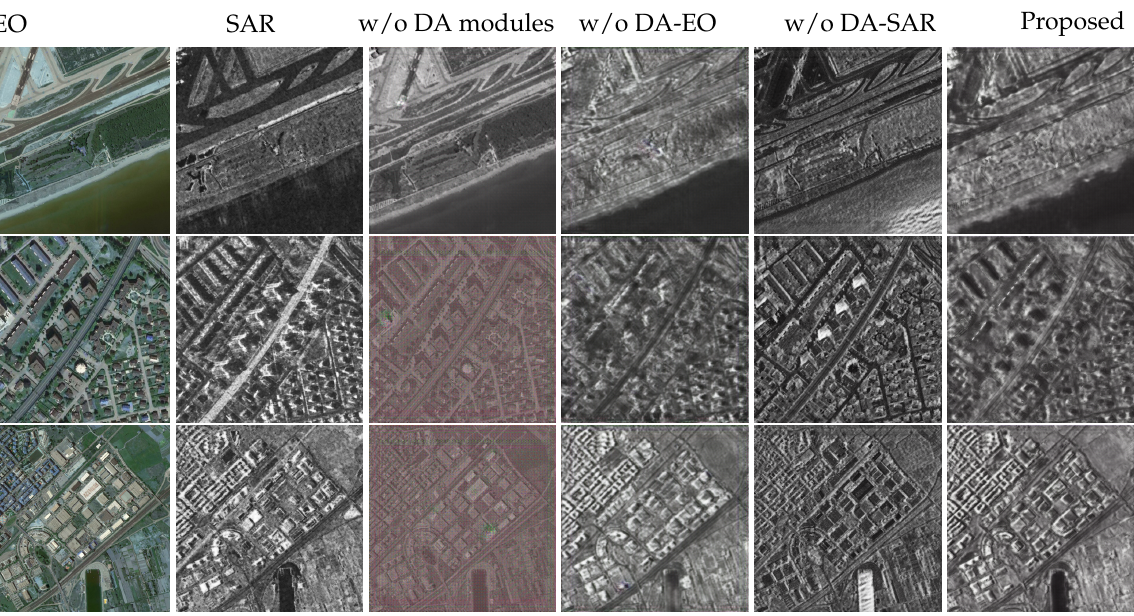
Figure 12. Ablation study: visual samples of different variants for the S2E translation task on the SAR2Opt dataset.